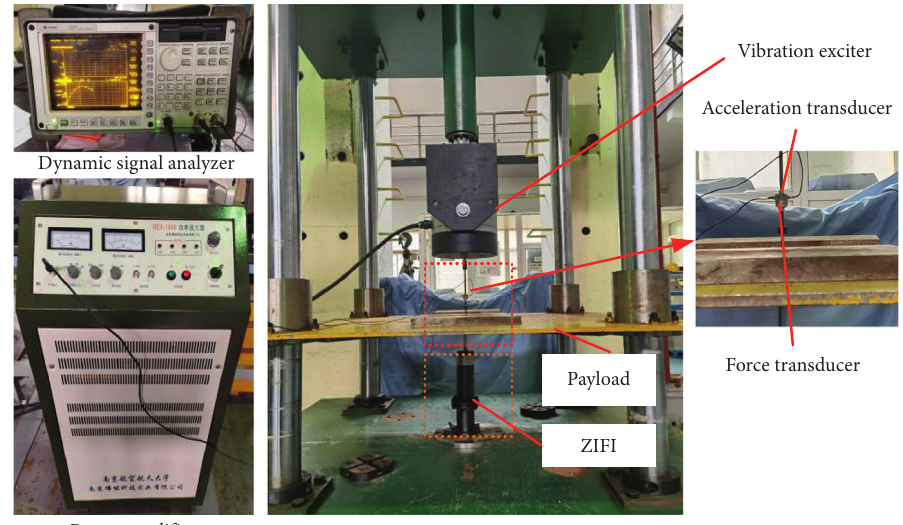
Figure 8: Dynamic experiment